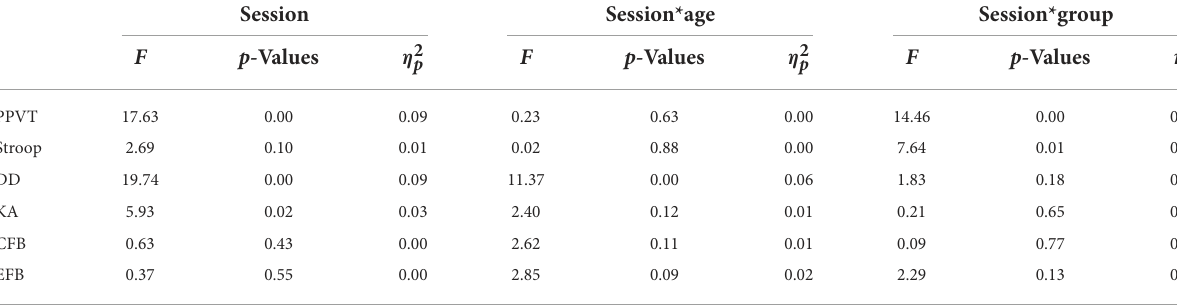
TABLE 3 Full statistics for the 2 (group: active reading control vs. control group) × 2 (session: pre vs. posttest) factorial ANOVAs. Session